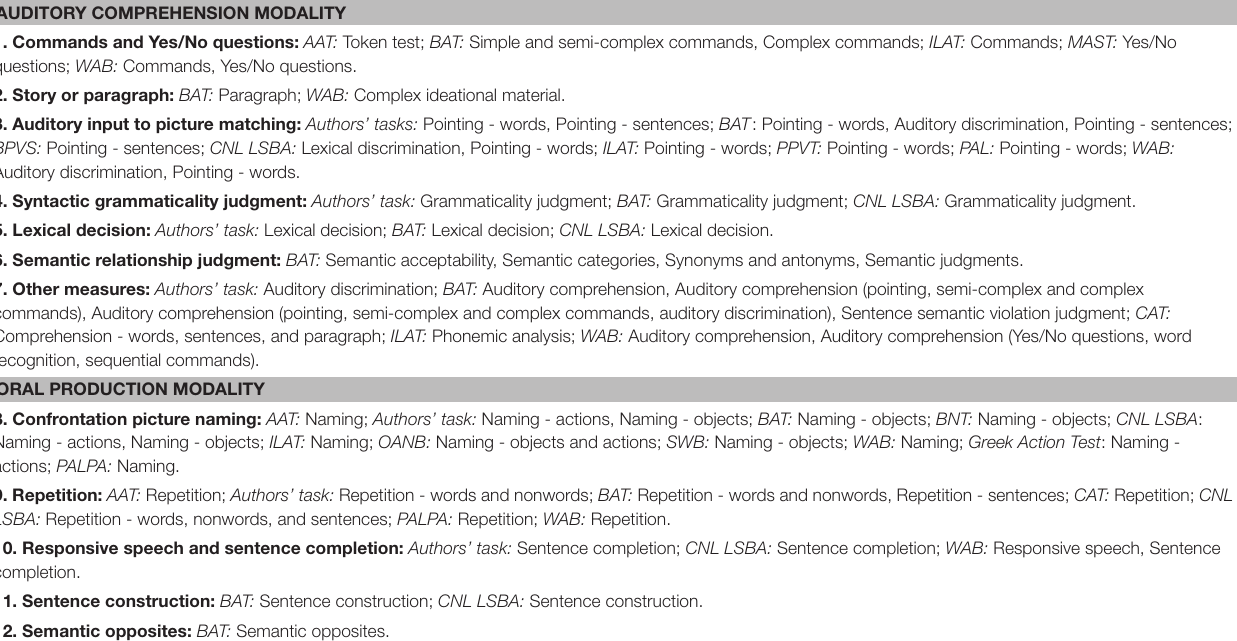
TABLE 1 | Summary of the included modalities, testing paradigms, and tests. AUDITORY COMPREHENSION